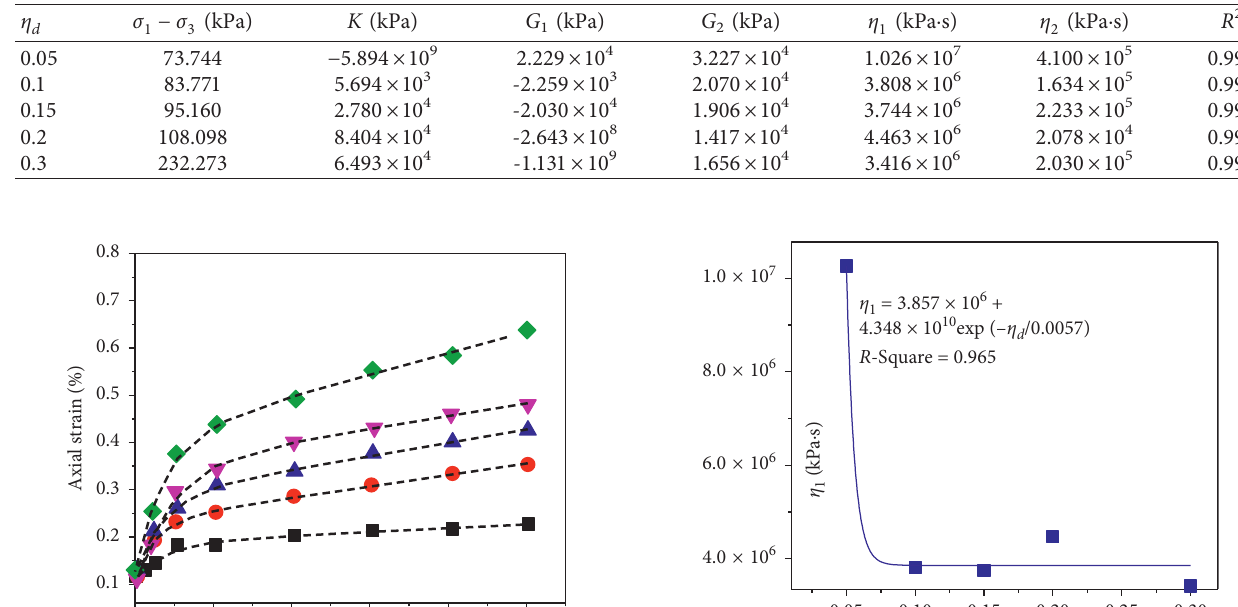
Table 3: NVPFM parameters of the water-rich soft rock under 20 kPa confining pressure when η